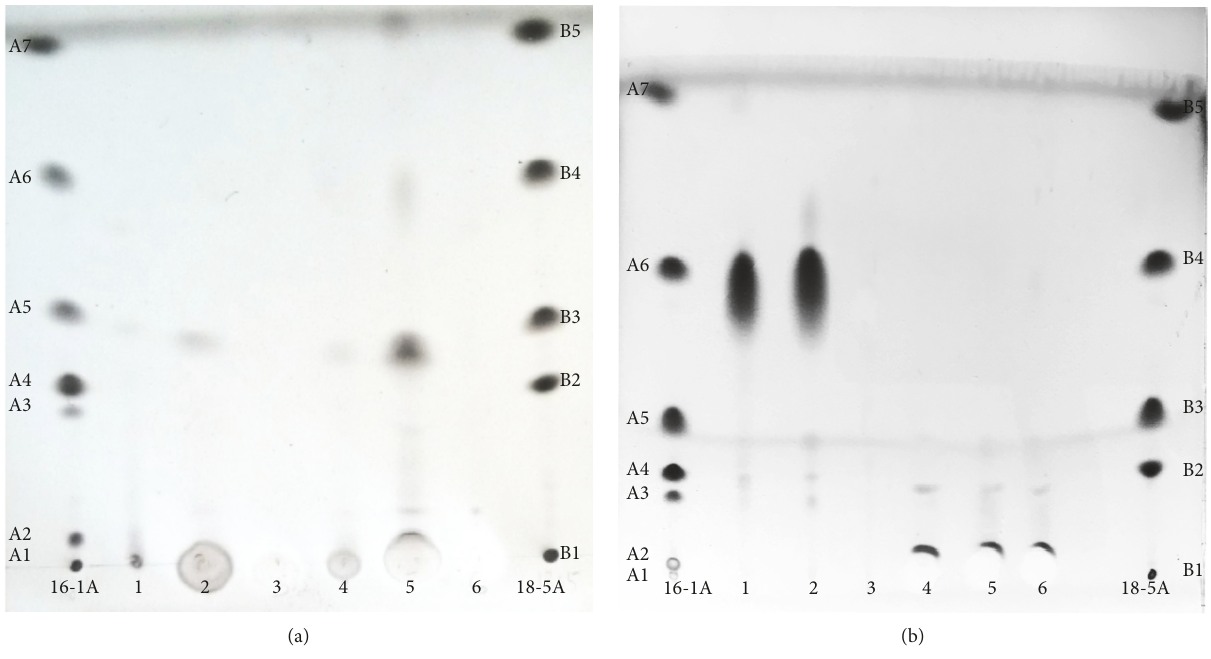
Figure 1: HP-TLC of oils (prior to extraction) and extracts. Fatty acid standards: 16-1A containing phospholipids (A1), monoacylglycerol (A2), diacylglycerol (A3), cholesterol (A4), free fatty acids (A5), triacylglycerol (A6), and cholesteryl ester (A7). 18-5A containing phospholipids (B1), cholesterol (B2), free fatty acids (B3), triacylglycerol (B4), and cholesteryl ester (B5). (a) Extracts: CWO-1 EtOAc (1), CWO-1 BuOH (2), CWO-1 H O (3), CWO-2 EtOAc (4), CWO-2 BuOH (5), and CWO-2 H O (6). (b) Oils before extraction: CLO (1) 2 2 and CWO (2) empty (3) extracts: CLO-1 H O (4), CLO-1 BuOH (5), and CLO EtOAc (6). HP-TLC =high performance thin-layer 2 chromatography; CWO=cold-pressed whale oil; CLO =cod liver oil; EtOAc=ethyl acetate; BuOH=butyl alcohol.